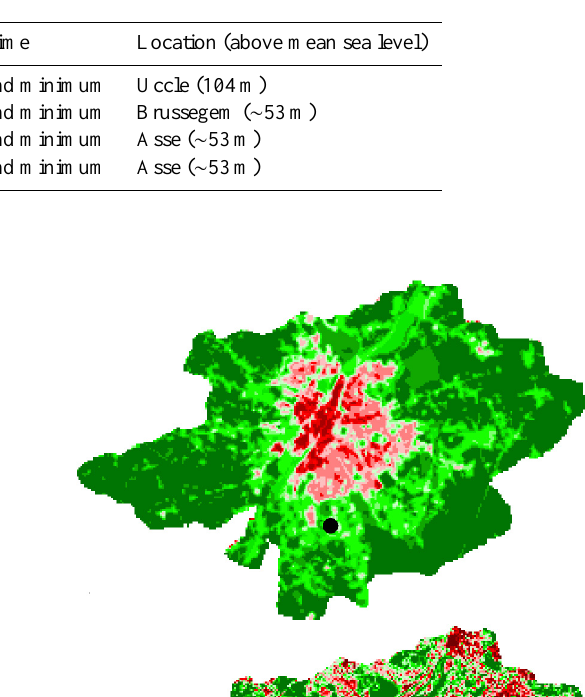
Table 1. Individual near-surface air temperature series used to estimate the urban warming of the city of Brussels, their observation hours, location and approximate elevation. No missing daily data were found in the datasets of the four climatological series.